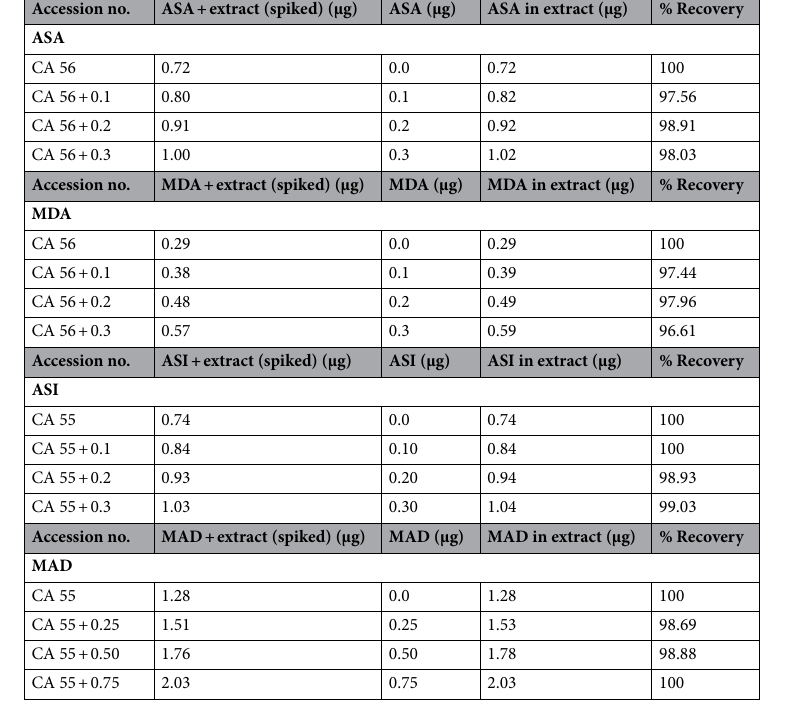
Table 3. Recovery data of ASA, MDA, ASI and MAD.